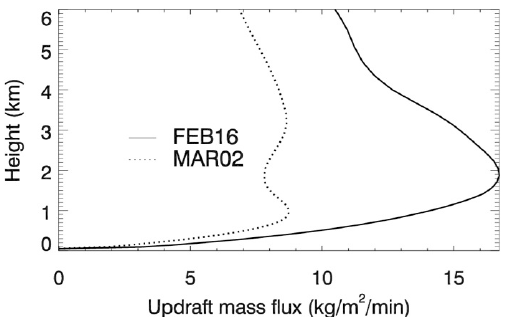
Fig. 15. Updraft mass fluxes averaged over the domain with terrain height within 200m and over 00:00–23:00UTC from the base run (LoCCN&Dust) for FEB16 and MAR02. The mass fluxes are cal- culated as (air density · vertical